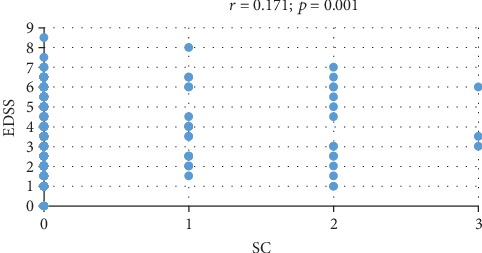
Correlation between the EDSS and SC.